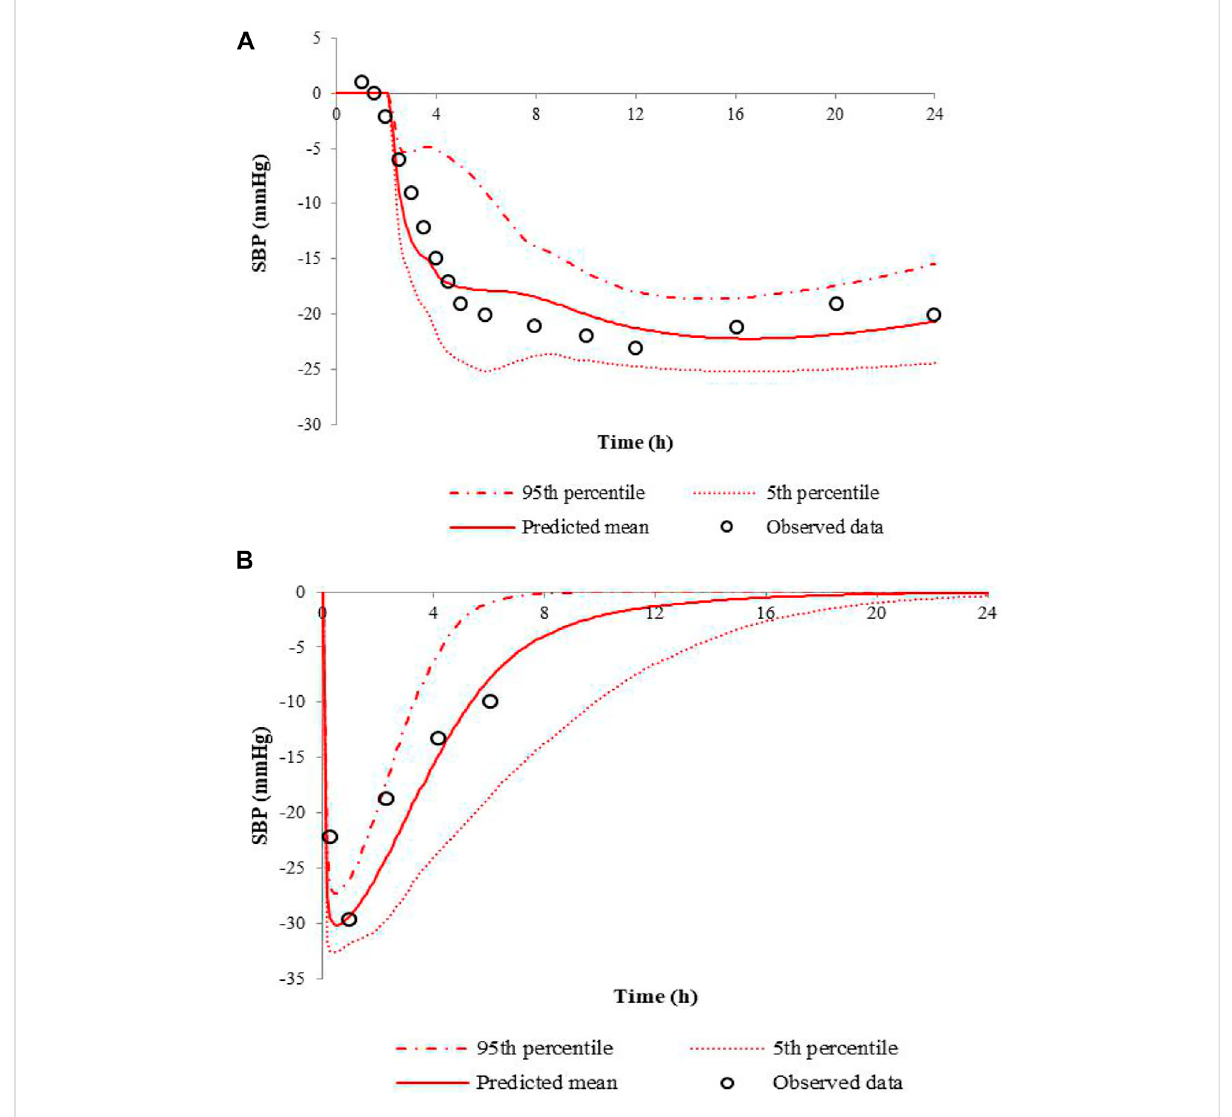
FIGURE 3 PredictedSBPchangesandclinicalobservationsinhypertensivepatientsatasingledoseof60 mgnifedipineCRtablet (A) ,and10 mgnifedipine IR tablet (B) .